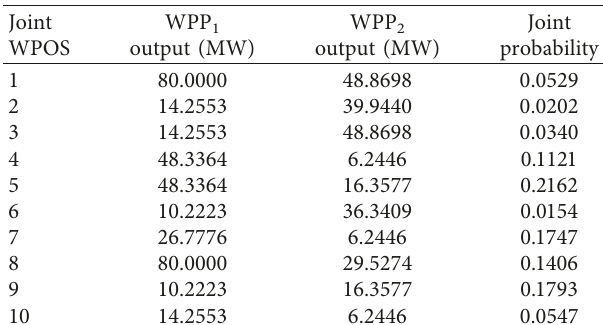
Table 2: Reduced joint real-time WPOSs and their corresponding probabilities.